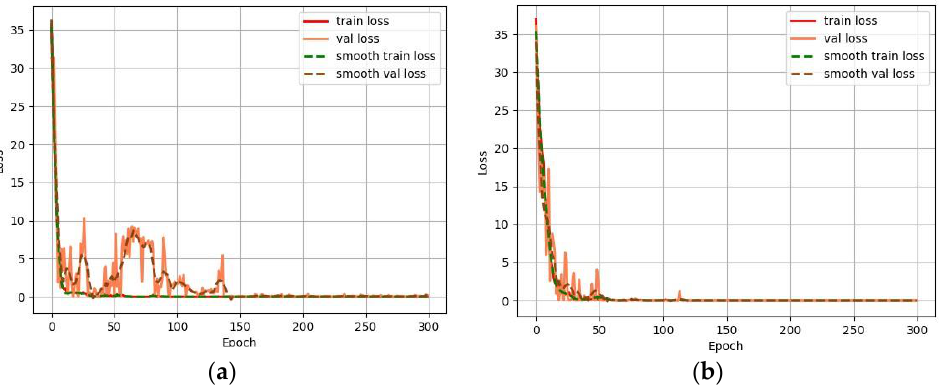
Figure 12. ( a ) Decline of the loss function before adjusting the order of BN layers; ( b ) decline of the